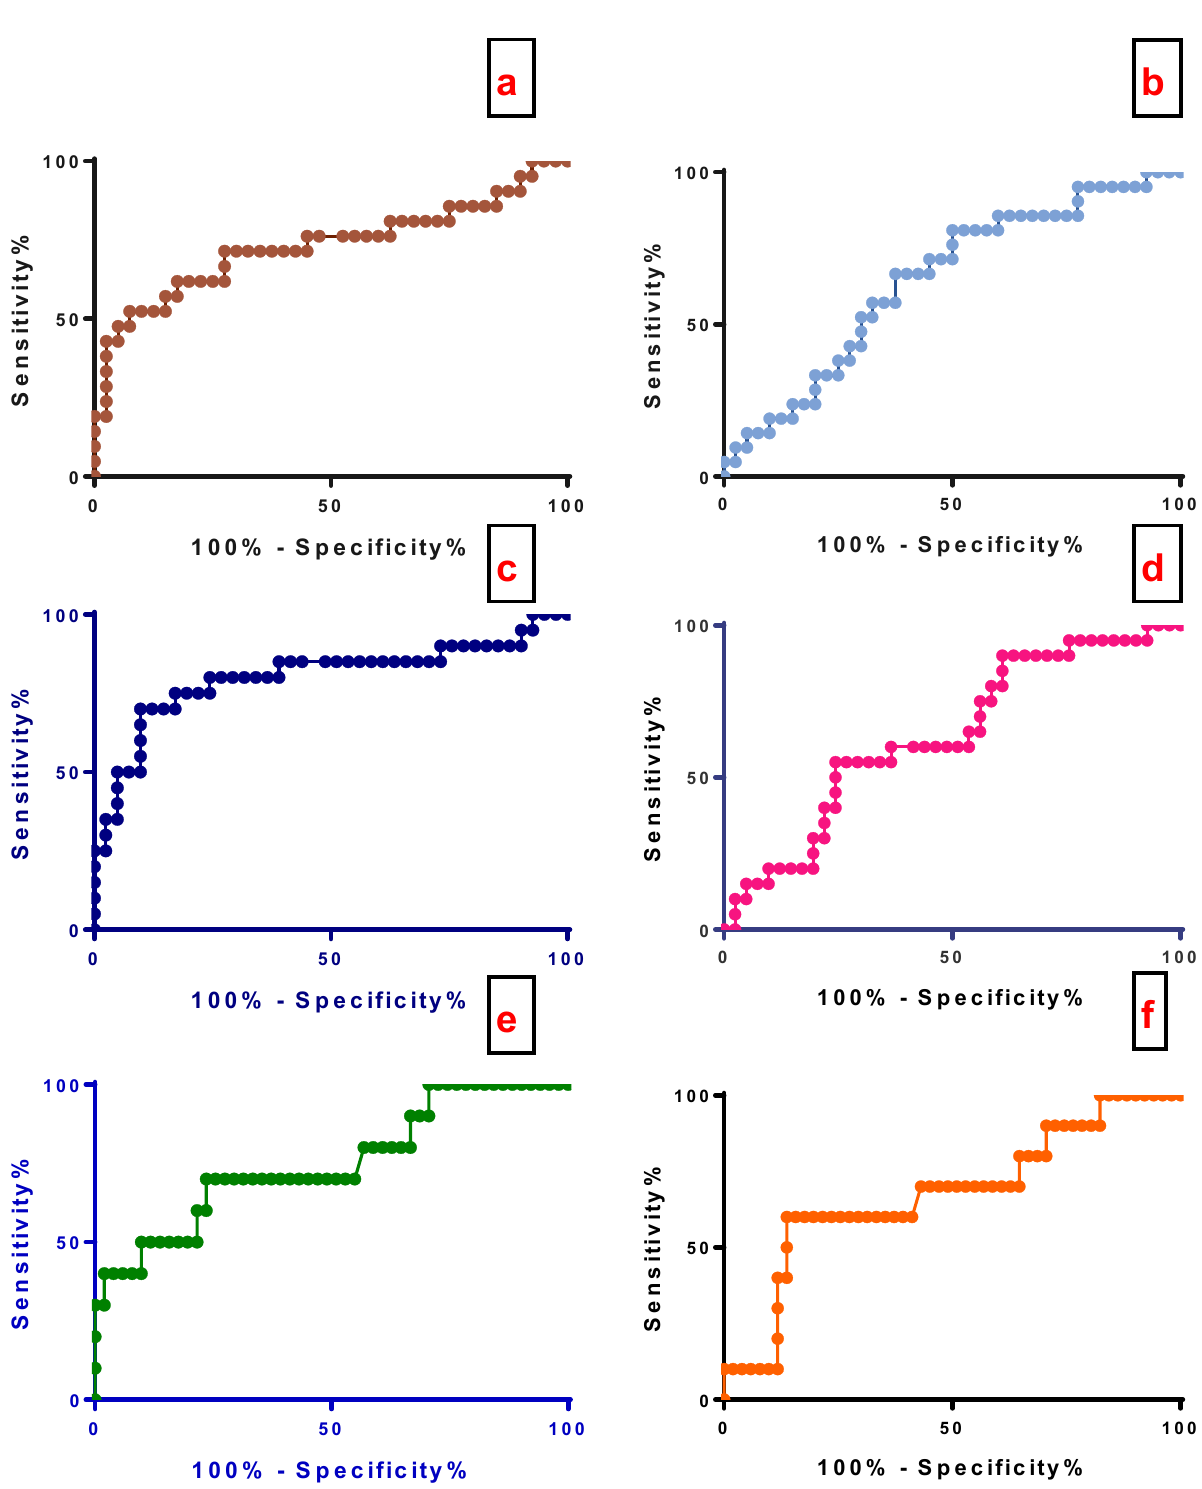
Figure 2: ROC curve of serum Hcy as a biomarker for prediction of grade 2-4 leucopenia(a), neutropenia(c) and thrombocytopenia(e). Serum VitB12 as a biomarker for prediction of grade 2-4 leucopenia(b), neutropenia(d) and